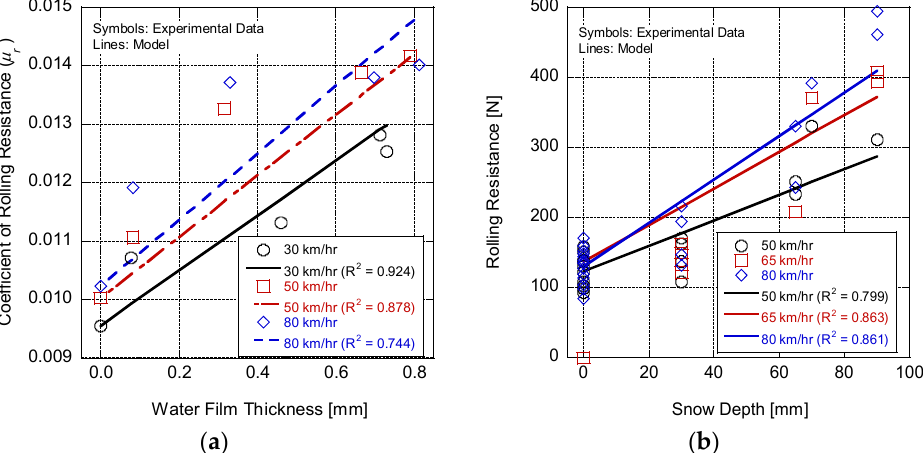
Figure 2. Comparison of rolling resistance model predictions and experimental data for ( a ) rain and ( b ) snow.